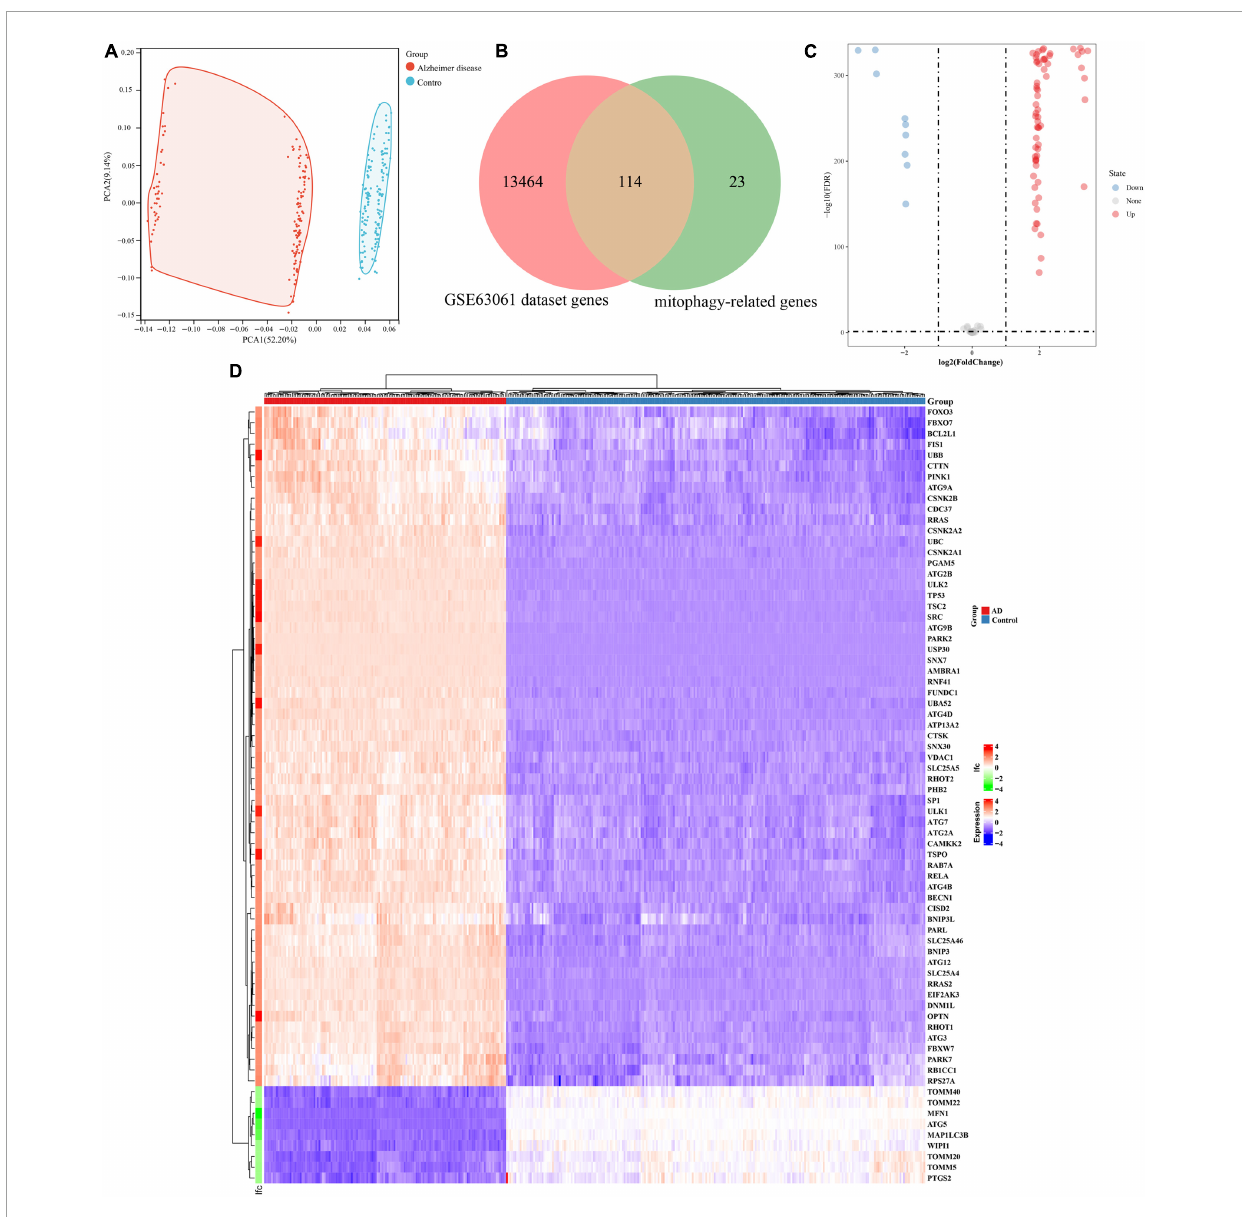
FIGURE2 Identification of differentially expressed genes involved in mitophagy in Alzheimer’s disease of GSE63061. (A) Principal component analysis of GSE63061. (B) Venn showing common genes between GSE63061 dataset and mitochondrial autophagy related genes. (C) Volcano of differentially expressed mitophagy-related genes. The red dots represent the significantly upregulated genes and the blue dots represent the significantly downregulated genes. (D) Heatmap of the differentially expressed mitophagy-related genes in Alzheimer’s disease and control